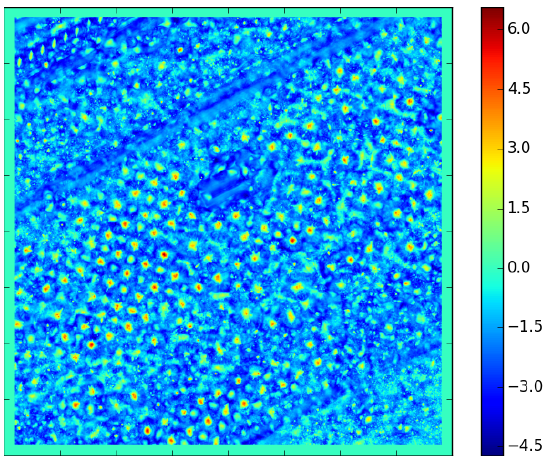
Figure 10: Feature map of Image 01